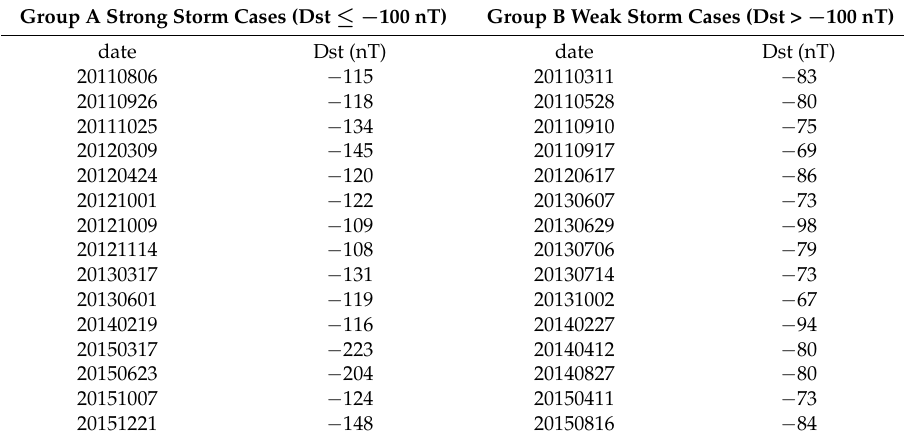
Table 2. Geomagnetic storms from 2011 to 2015 in solar cycle